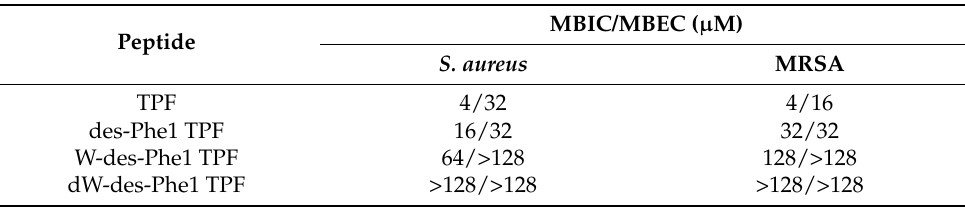
Table 4. The minimal biofilm inhibitory concentrations (MBIC) and minimal biofilm eradication concentrations (MBEC) of Temporin-PF and the synthetic analog peptides against S. aureus and MRSA .